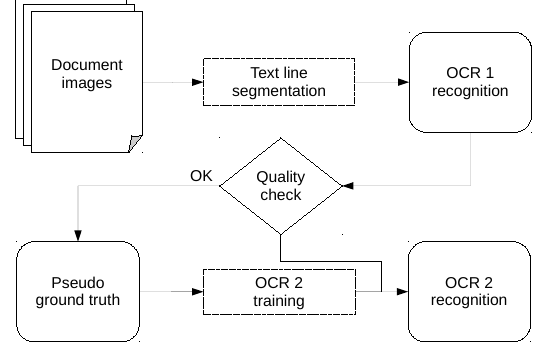
Figure 4. The complete pipeline of the segmentation-free OCR system. The first row represents traditional text recognition sequence. In the middle block, text lines are quality checked, and the good ones (text line images and associated transcriptions) are used as pseudo ground truth for training the OCR 2. Final OCR output is produced by OCR 2 using its automatically trained